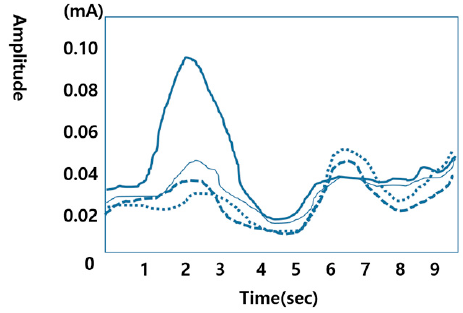
Figure 4. ERS/ERD Figure 4. ERS/ERD Signal.